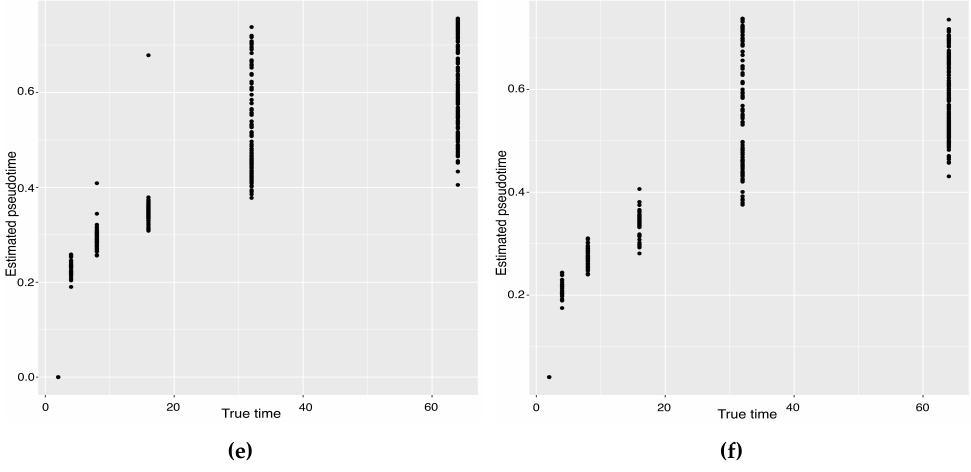
Figure 7. Scatter plots between estimated pseudotimes and true times for our approach and four existing TR methods on the Zygote–Blastocyst dataset. ( a ) SLICER. ( b ) Slingshot. ( c ) Monocle ICA. ( d ) Monocle DDRTree. ( e ) Linear Tree. ( f ) Curved